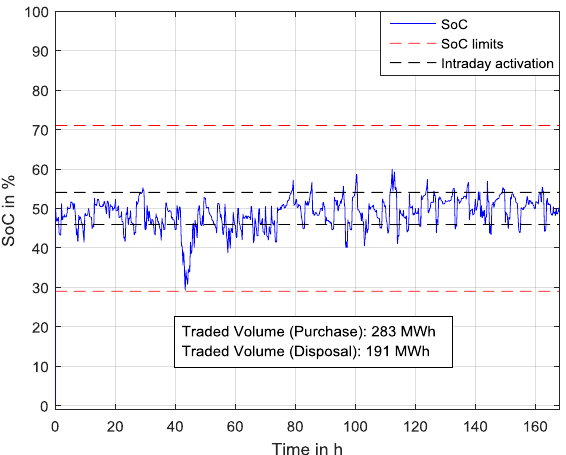
Figure 5. SoC characteristics for different DoFs.